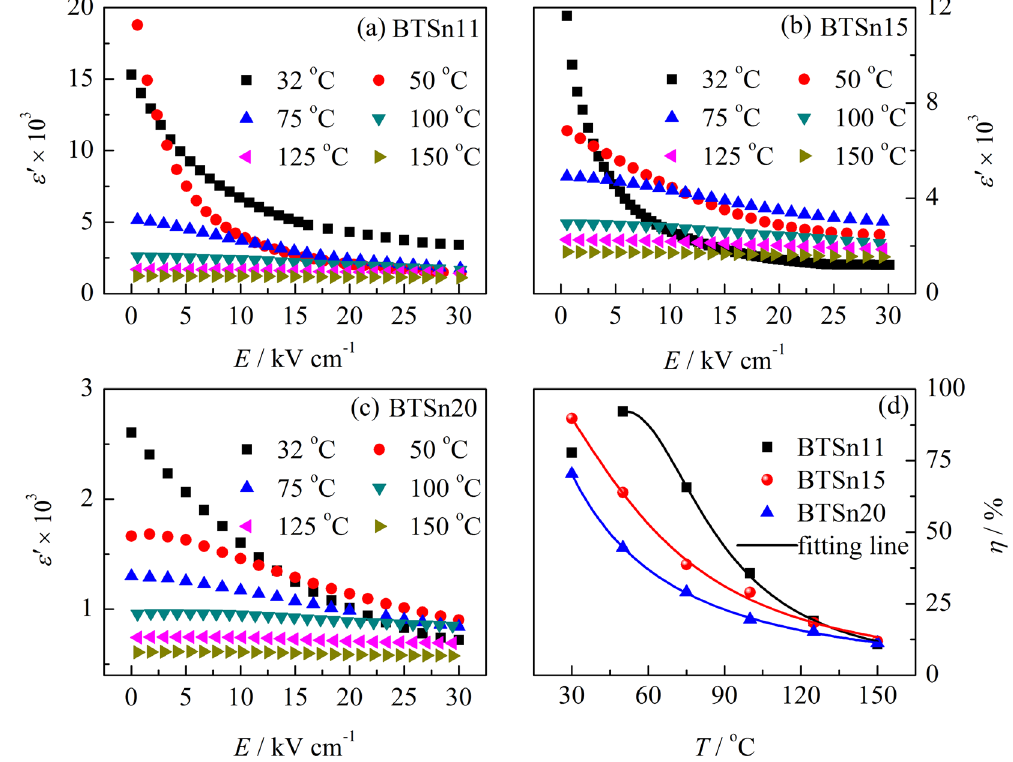
Figure 6. ( a–c ) Dielectric permittivity as a function of dc electric field of BTSn11, BTSn15 and BTSn20 from bias electric field measurement taken at 10 kHz and at different temperatures; ( d ) dielectric tunability of BTSn11, BTSn15 and BTSn20 at different